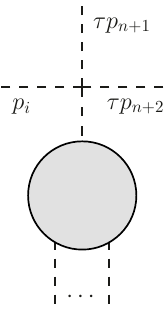
Figure 12 . The pole diagram in the double soft